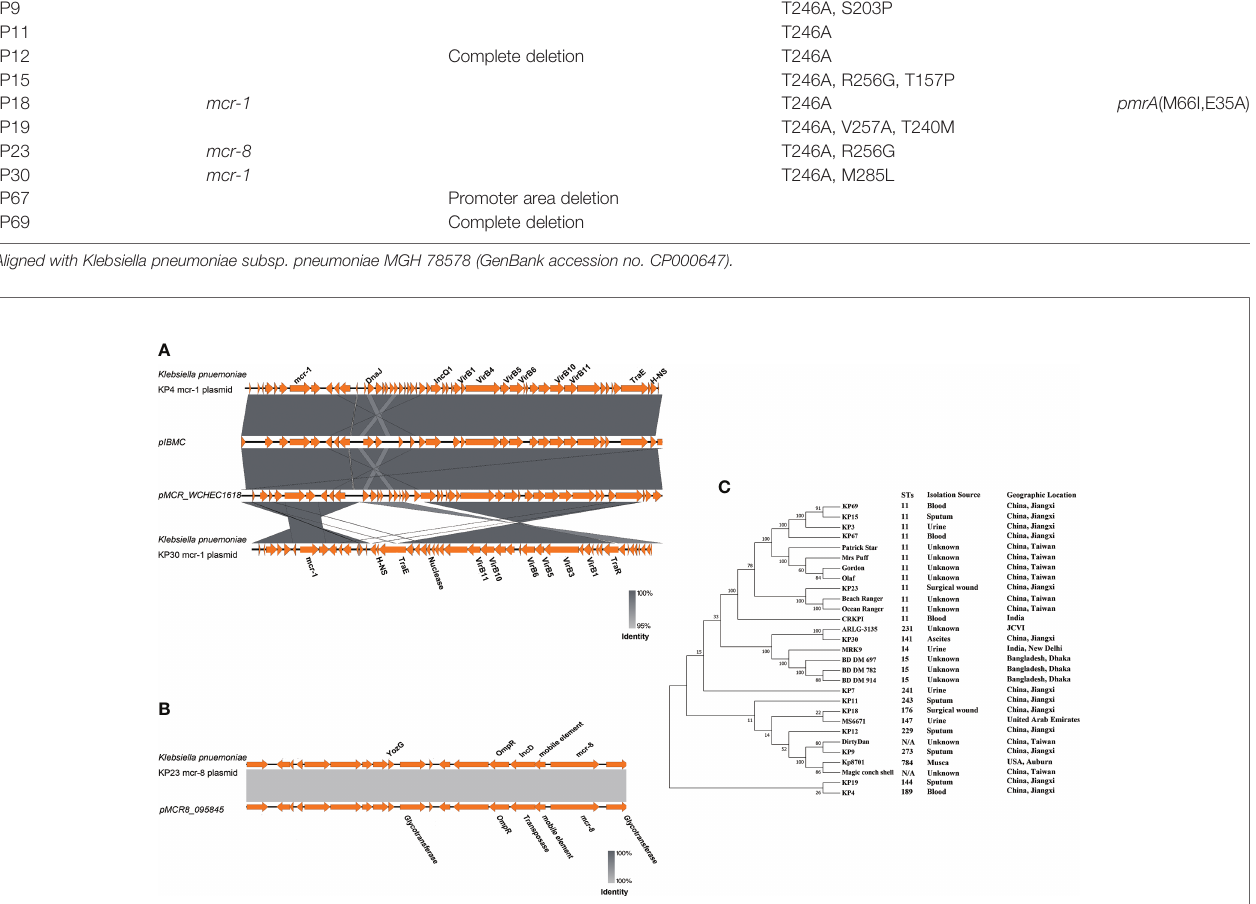
FIGURE 1 | Comparative analysis of COLR-KP. (A) Comparative analysis of mcr-1 related plasmids. (B) Comparative analysis of mcr-8 related plasmids. (C) Phylogenetic analysis of core genes for COLR-KP from different area. Core genes are those genes existed in all K. pneumoniae genomes in this study, which were produced by a pan genome analysis using Roary pipeline (e value = 1e-5, identity = 90, coverage = 90).